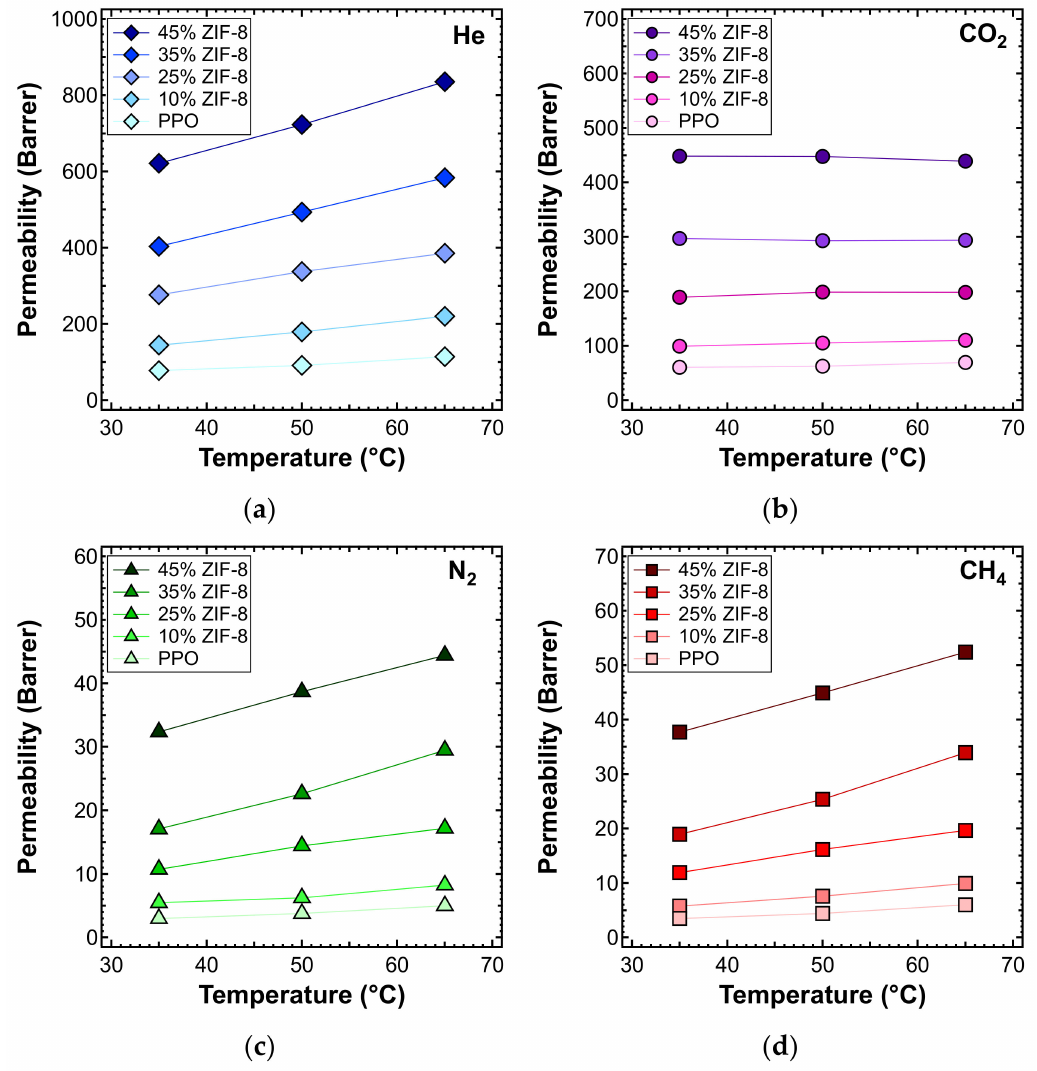
Figure 14. Permeability of ( a ) He, ( b ) CO 2 , ( c ) N 2 , and ( d ) CH 4 at di ff erent temperatures, in the ZIF-8 / PPO MMMs of di ff erent weight fractions of ZIF-8, from 0% to 45%. Table 5. Activation energy of permeability in the range of 35–65 ◦ C for ZIF-8 / PPO MMMs at di ff erent filler